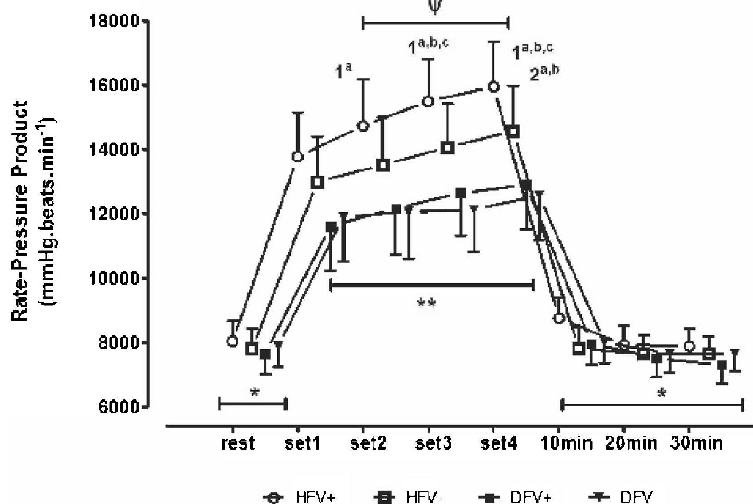
Figure 3 - The rate-pressure product at rest, at the end of each stretching set, and 30 min post-exercise. Within-group comparison, -. *, significant differences in all sets (a: HFV + , hip flexion with Valsalva; b: HFV-, hip flexion without Valsalva; c: DFV + , dorsiflexion with Valsalva; d: DFV-, dorsiflexion without Valsalva) (p , .05). The superscripted alpha-numeric codes indicate significant differences in the indicated set of exercise protocols specified by the letters (p , .05). Between-group comparison, -. **, significant differences for HFV + and HFV- as compared to DFV + and DFV- (1 st through 4 th sets). y , a significant difference between HFV + and HFV- (2 nd through 4 th sets). The vertical bars denote 0.95 confidence